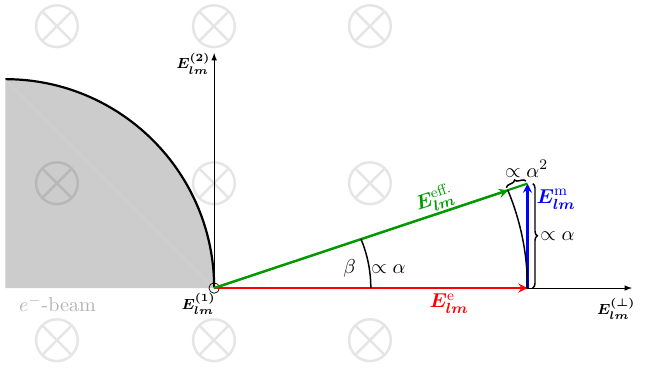
(cid:0) (cid:1) E m components to an electric lm